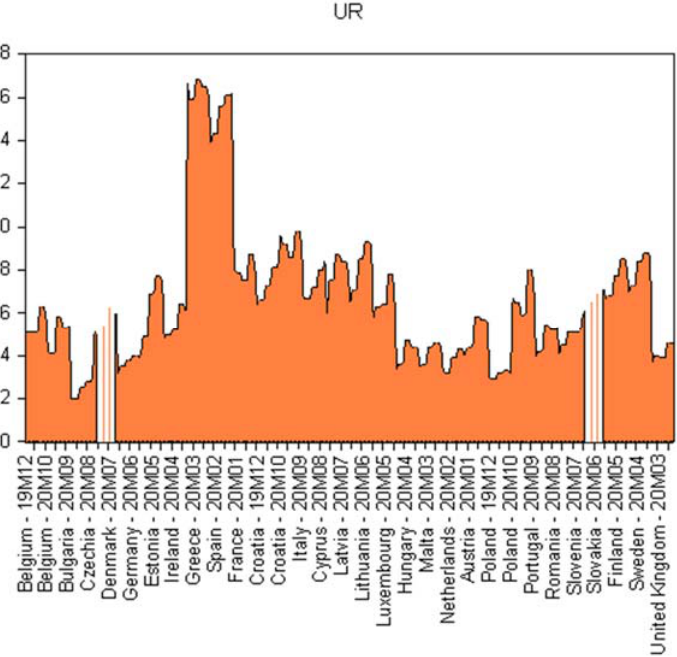
Figure 5. Evolution of total unemployment rate ( UR ) across the country sample. Note : Figures displayed after the symbol M indicate the number of the month in the calendar year.